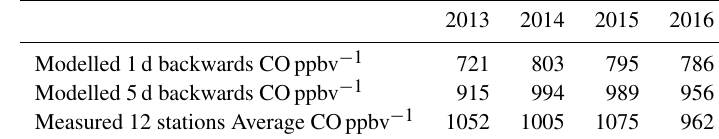
Table 3. Yearly averages of the 1 and 5d modelled CO and the measured average Beijing CO in parts per billion by volume (ppbv).